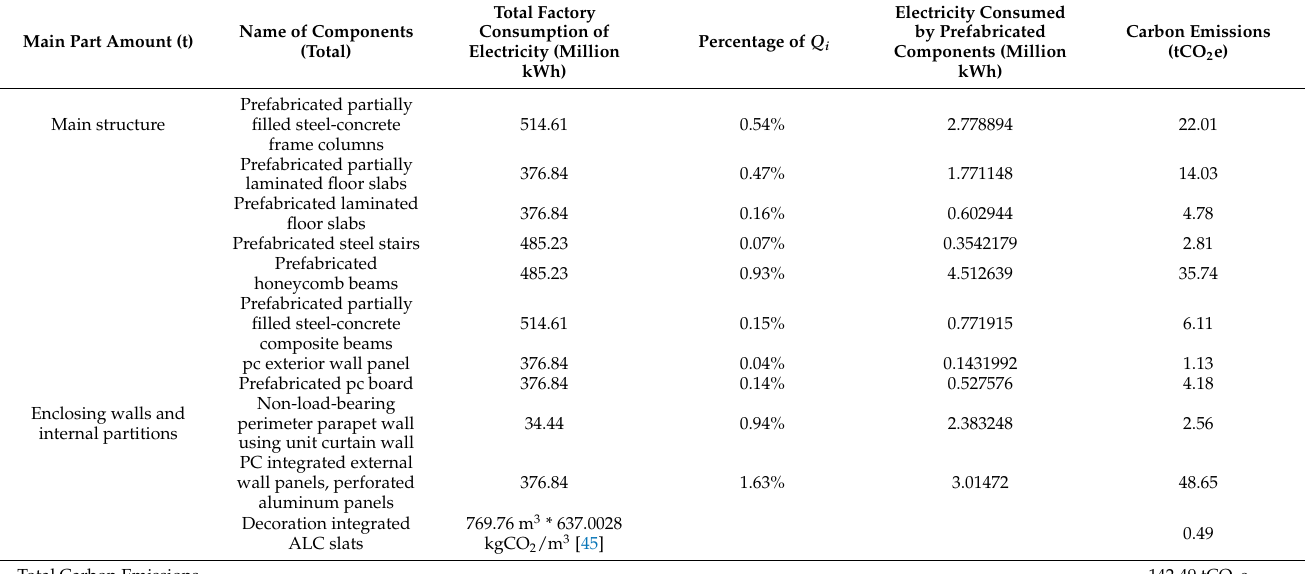
Table 9. Carbon emissions of W p i .